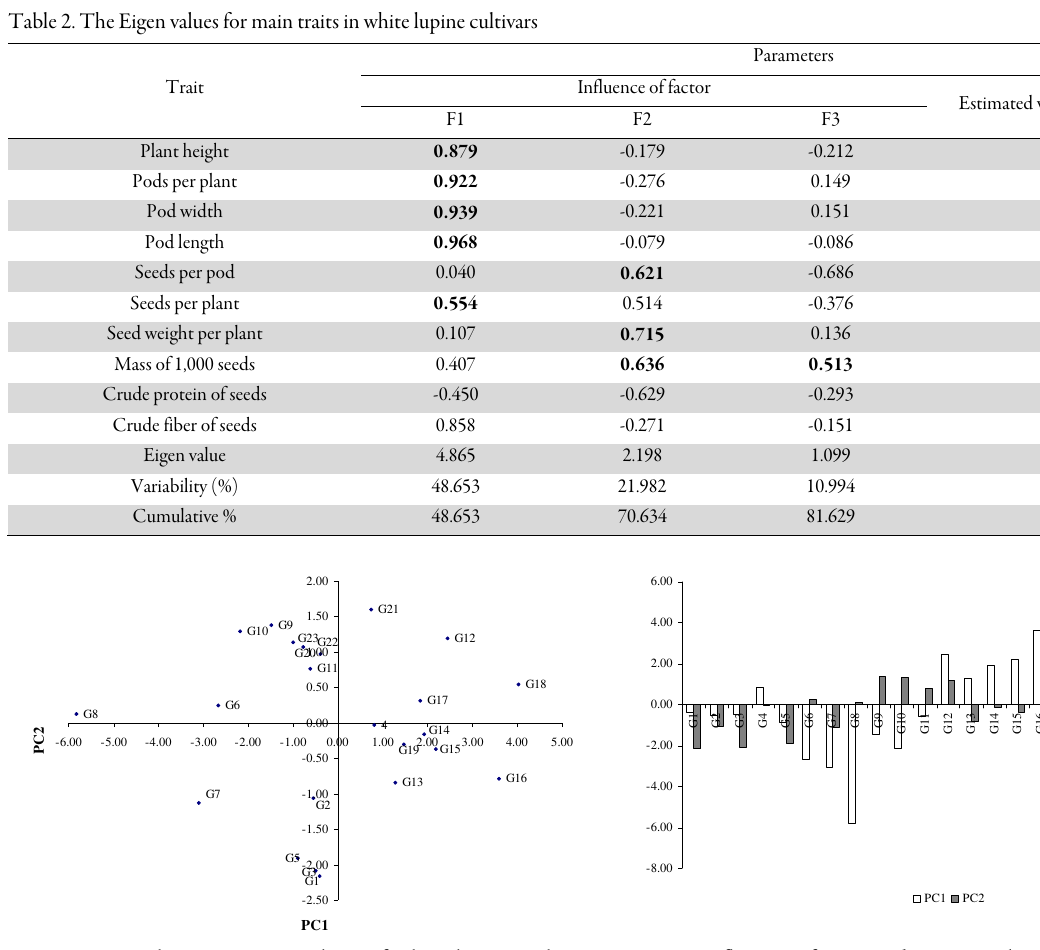
Fig. 1. Principal component analysis of white lupine cultivars regarding the studied traits. 1-‘Astra’, 2-‘Nahrquell’, 3-‘Ascar’, 4-‘BGR 6305’, 5-‘Shienfield Gard’, 6-‘WAT’, 7-‘Kijewskij Mutant’, 8-‘Hetman’, 9-‘Start’, 10-‘Amiga’, 11-‘Garant’, 12- ‘Tel Keram’, 13-‘Bezimenii 1’, 14-‘Bezimenii 2’, 15-‘Pflugs Ultra’, 16-‘Termis Mestnii’, 17-‘Horizont’, 18-‘Solnechnii’, 19- ‘Pink Mutant’, 20-‘Manovitskii’, 21-‘Barde’, 22-‘Dega’, 23- ‘Desnyanskii’